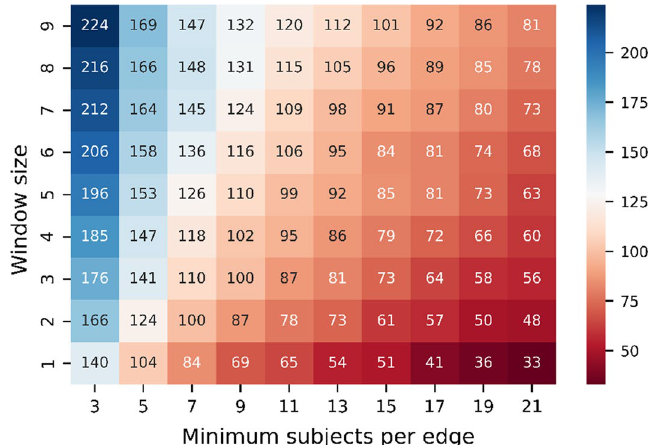
Fig. 2 Vertices on which the correlation test was performed. Each cell represents the number of vertices for a pair of parameters MS (minimum subjects per edge) and WS (window size). The x-axis denotes the range of MS values, and the y- axis denotes the range of WS values. The color highlights the number of vertices. As the cells increase in redness, the number of vertices decreases